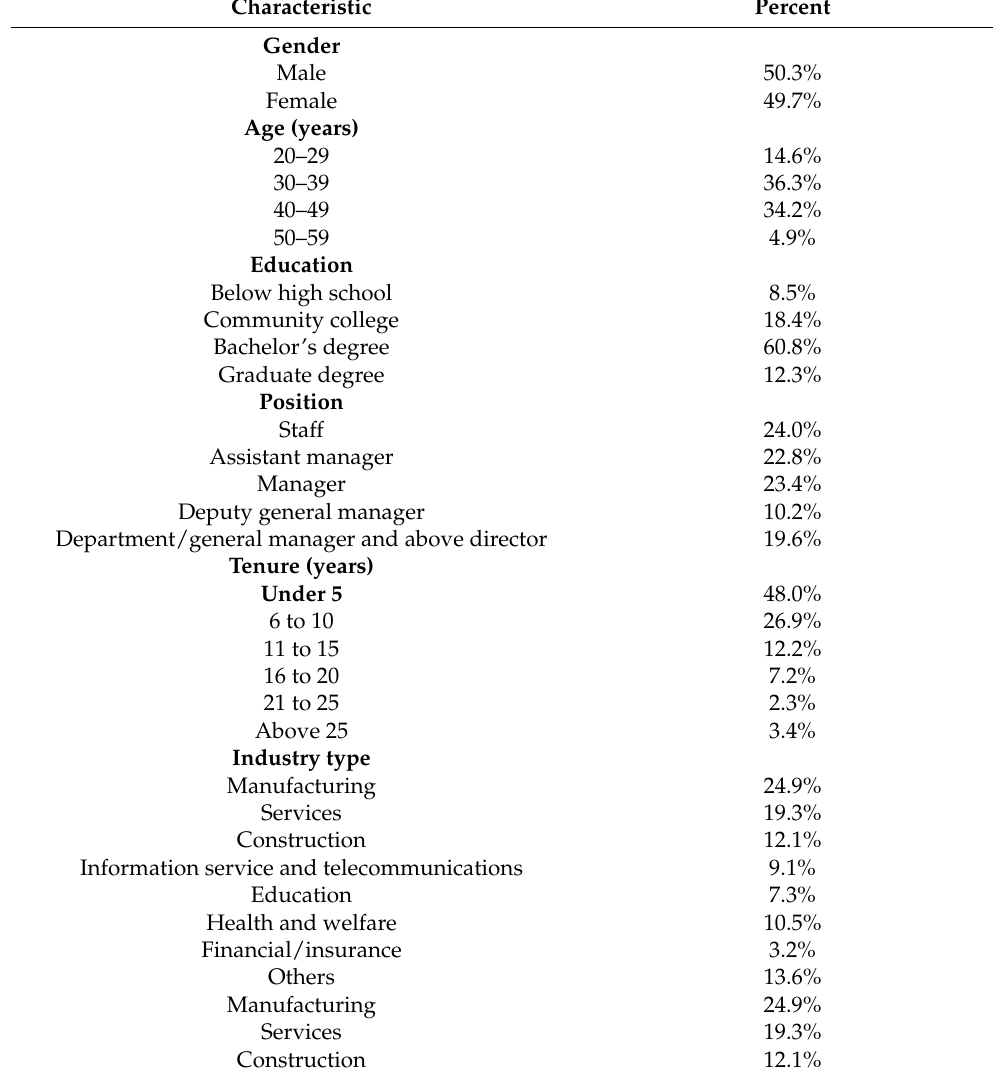
Table 1. Descriptive features of the